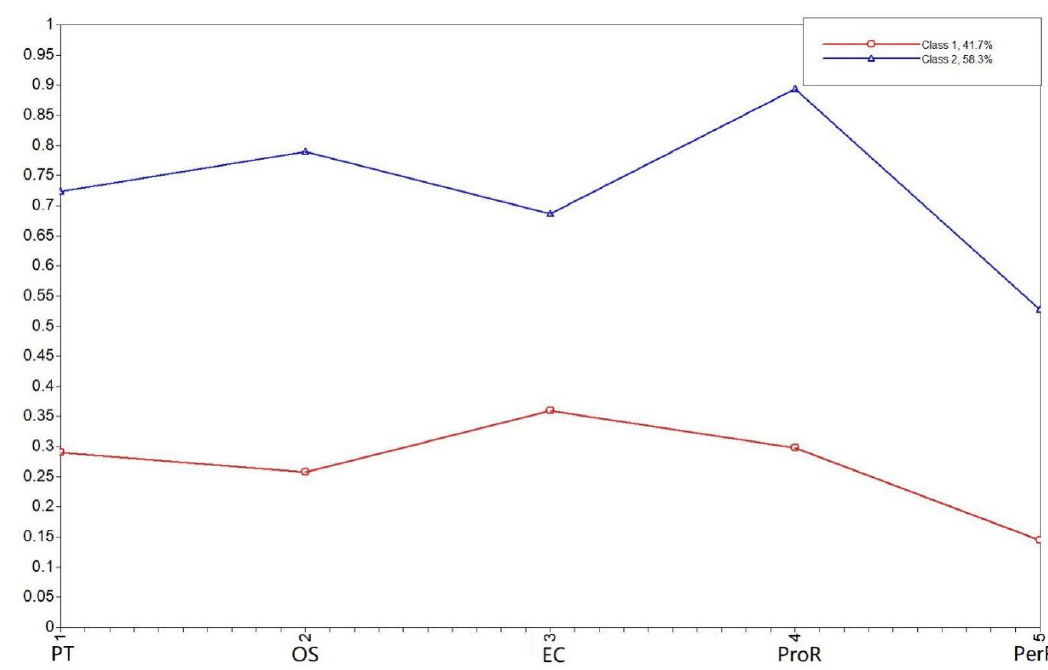
Figure 5. Class-specific response probabilities for each of five subscales of Empathy in Russian Group. Note: PT means Perspective Taking; OS—Online simulation; EC—Emotion Contagion; ProR—Proximal Responsivity; PerR—Peripheral Responsivity.